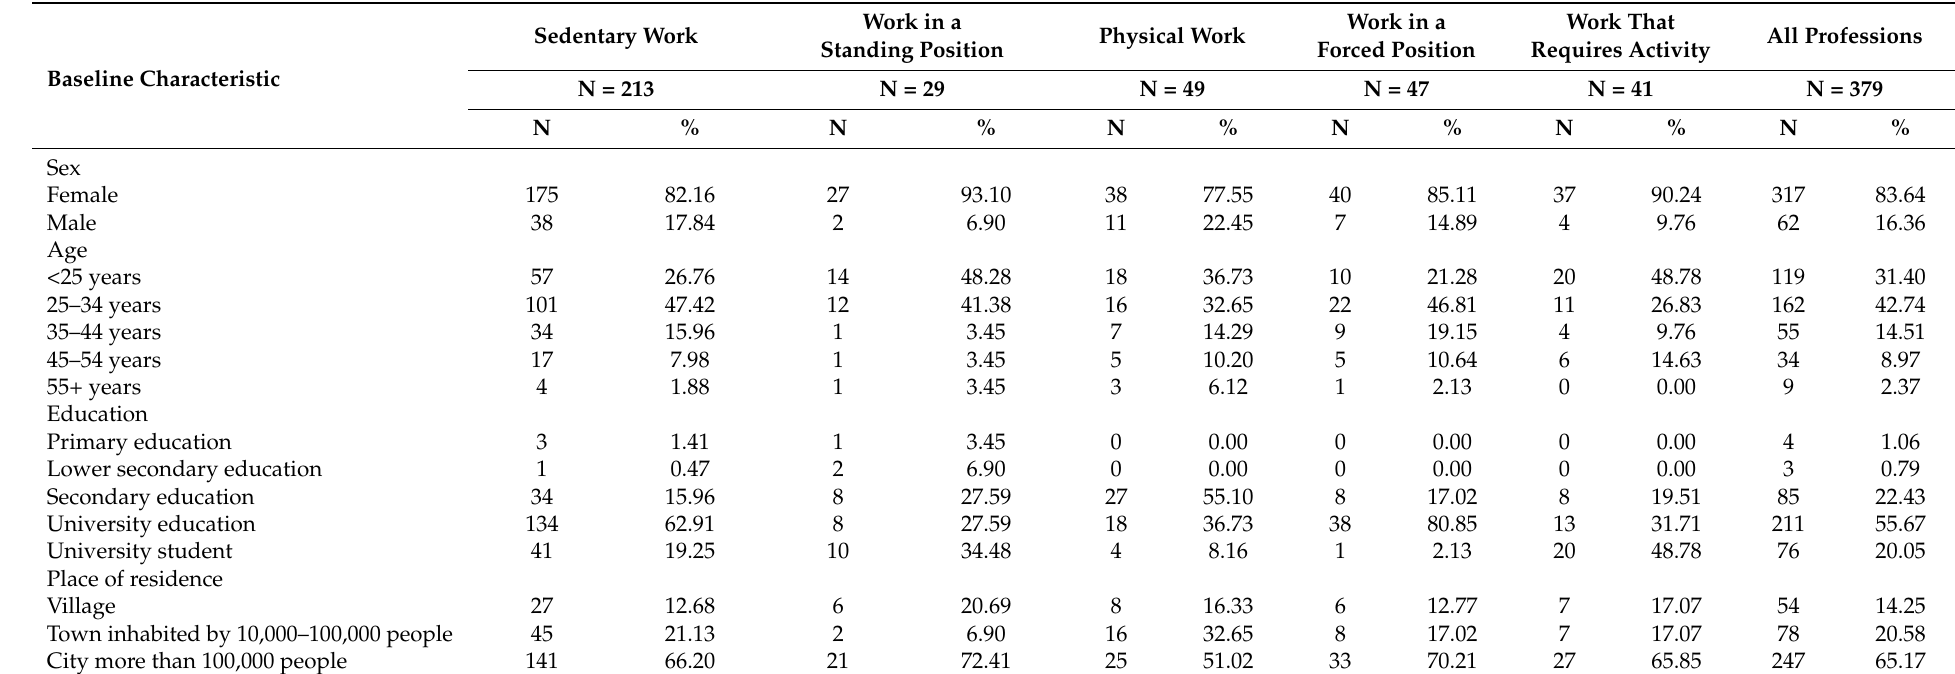
Table 1. General information about